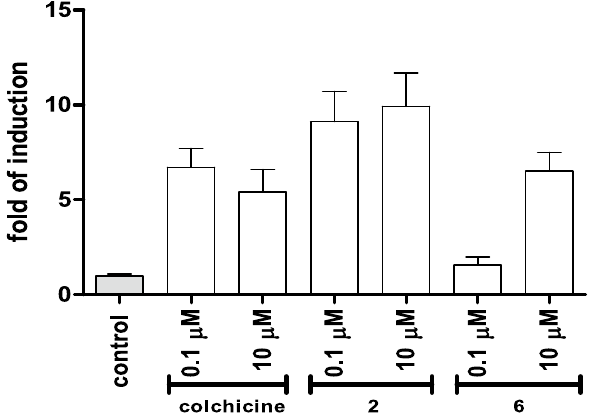
Figure 6. Impact of tested compounds: colchicine, 2 and 6 on Caspase 3/7 activation in SKOV-3 cells. Cells were treated with tested compounds at concentrations 0.1 μM, and 10.0 μM for 24 h. All tested groups were significantly different from control group, p < 0.001, except group treated with compound 6 at concentration 0.1 µM, p < 0.01.